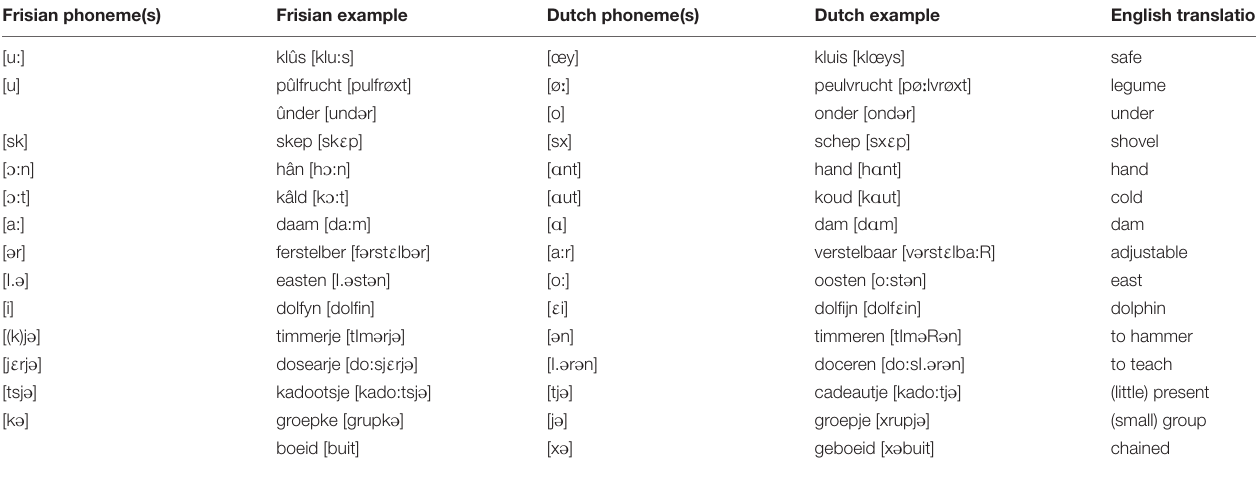
TABLE 2 | Cross-linguistic phonological regularities category 2. Frisian phoneme(s) Frisian example Dutch phoneme(s) Dutch example English